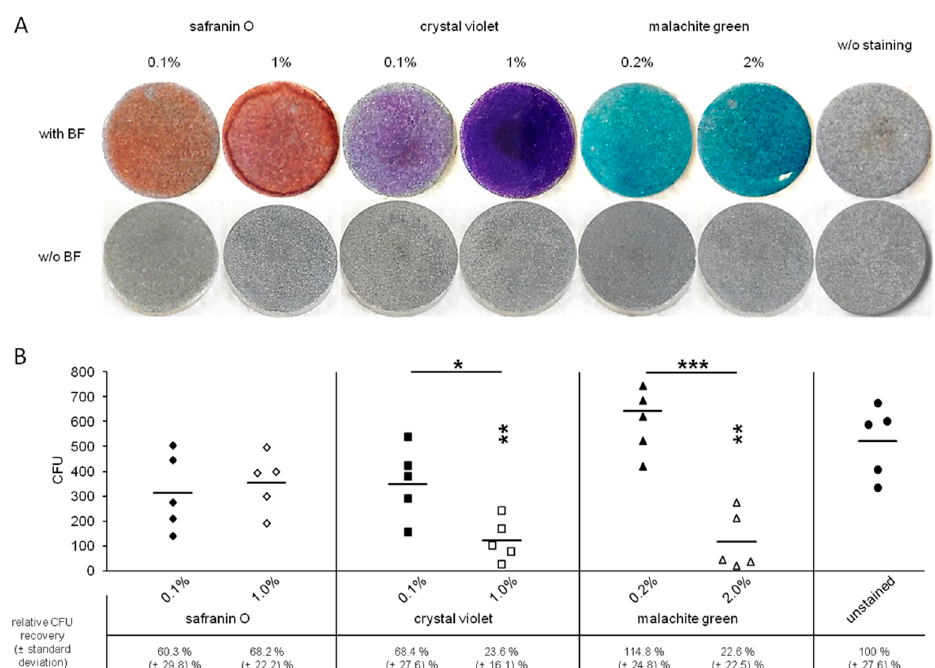
Figure 2. Staining and sampling of titanium alloy biofilm carriers. S. epidermidis biofilms (BF) were grown for three days on titanium alloy specimens. Biofilms were stained with safranin O (0.1% and 1% ( w/v )), crystal violet (0.1% and 1% ( w/v )), or malachite green (0.2% and 2% ( w/v )). Representative images of stained biofilms (upper row) as well as of stained biofilm-negative titanium alloy specimens (lower row) are given ( A ). Biofilms were sampled by swabbing and subsequently microbiologically analyzed by roll-plate method on Columbia agar plates. Recovered CFUs and geometric means are given in the lower panel ( B ). Each staining setup was compared to unstained control discs. The respective significance levels are indicated by asterisks above each column. Significance levels between different stain concentrations are given above each pair of columns and indicated by a bar. Significance levels are as follows: * p < 0.05; ** p < 0.01; *** p < 0.001 (Student’s t -test, unpaired, two-tailed, heteroscedastic). Relative CFU recovery rates compared to unstained control discs are given below the graph. Shown are data of five independent